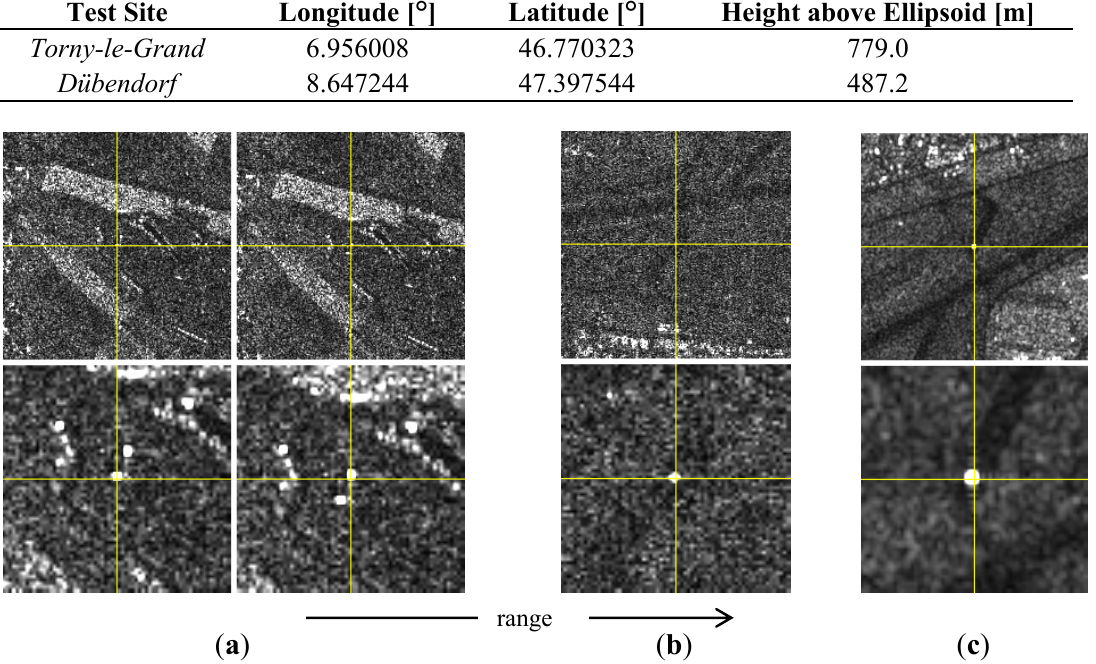
Figure 2. Corner reflectors as seen in S1A StripMap products, with predicted positions indicated by the yellow crosshairs in each case and a higher zoom level at the bottom; ( a ) SLC over Torny-le-Grand , north-west reflector ( left ) and south-west reflector ( right ),